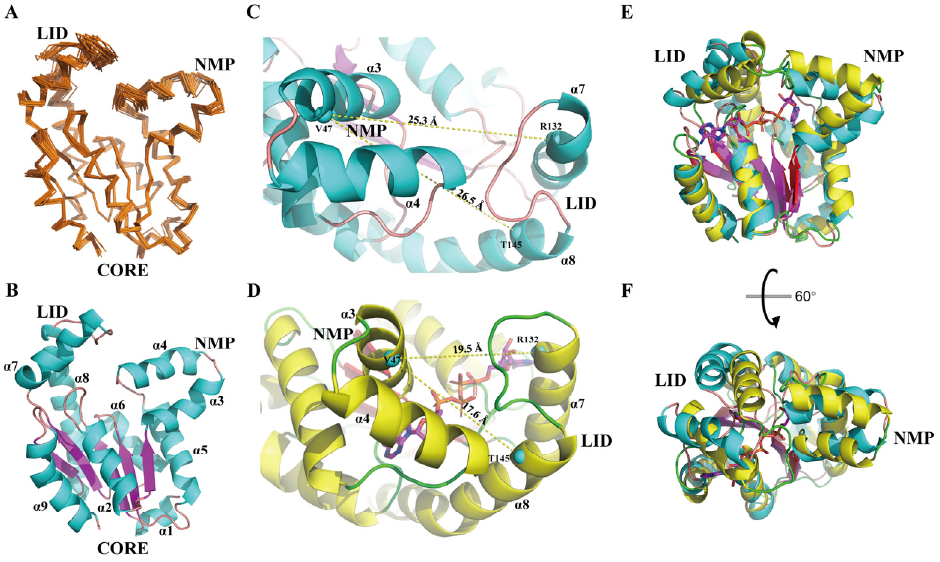
Figure 1. Standalone and comparative representation of the apo- h AK1 structure. ( A ) Superposition of 20 lowest-energy structures of apo- h AK1 represented as ribbons (PDB ID: 7X7S). ( B ) Mean structure of apo- h AK1 depicted in cartoon. α -helices and β -strands are colored in cyan and purple, respectively. ( C ) Conformation of NMP and LID domains in apo- h AK1. ( D ) Conformation of NMP and LID domains in the h AK1-B 4 P complex (PDB ID: 2C95). The C α atoms of V47 in α 3, R132 in α 7 and T145 in α 8 are selected to optimally exhibit the distances between α 3 and α 7 or α 8 , which are displayed as cyan spheres. The α -helices of apo- h AK1 and B 4 P-complexed h AK1 are colored in cyan and yellow, respectively. ( E , F ) Superposition of 7X7S ( α -helices in cyan and β -strands in purple) and 2C95 ( α -helices in yellow and β -strands in red) structures. 7X7S atom coordinates were RMS fitted to Table 1. NMR restraints and structural statistics for h AK1.